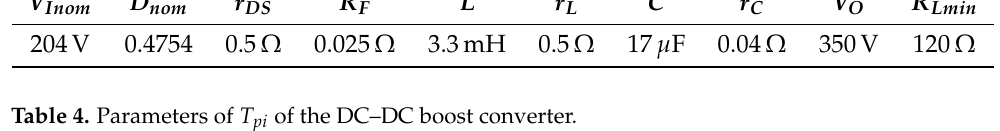
Table 3. Parameters of the designed DC–DC boost converter for controlling the PV array’s output. V Inom